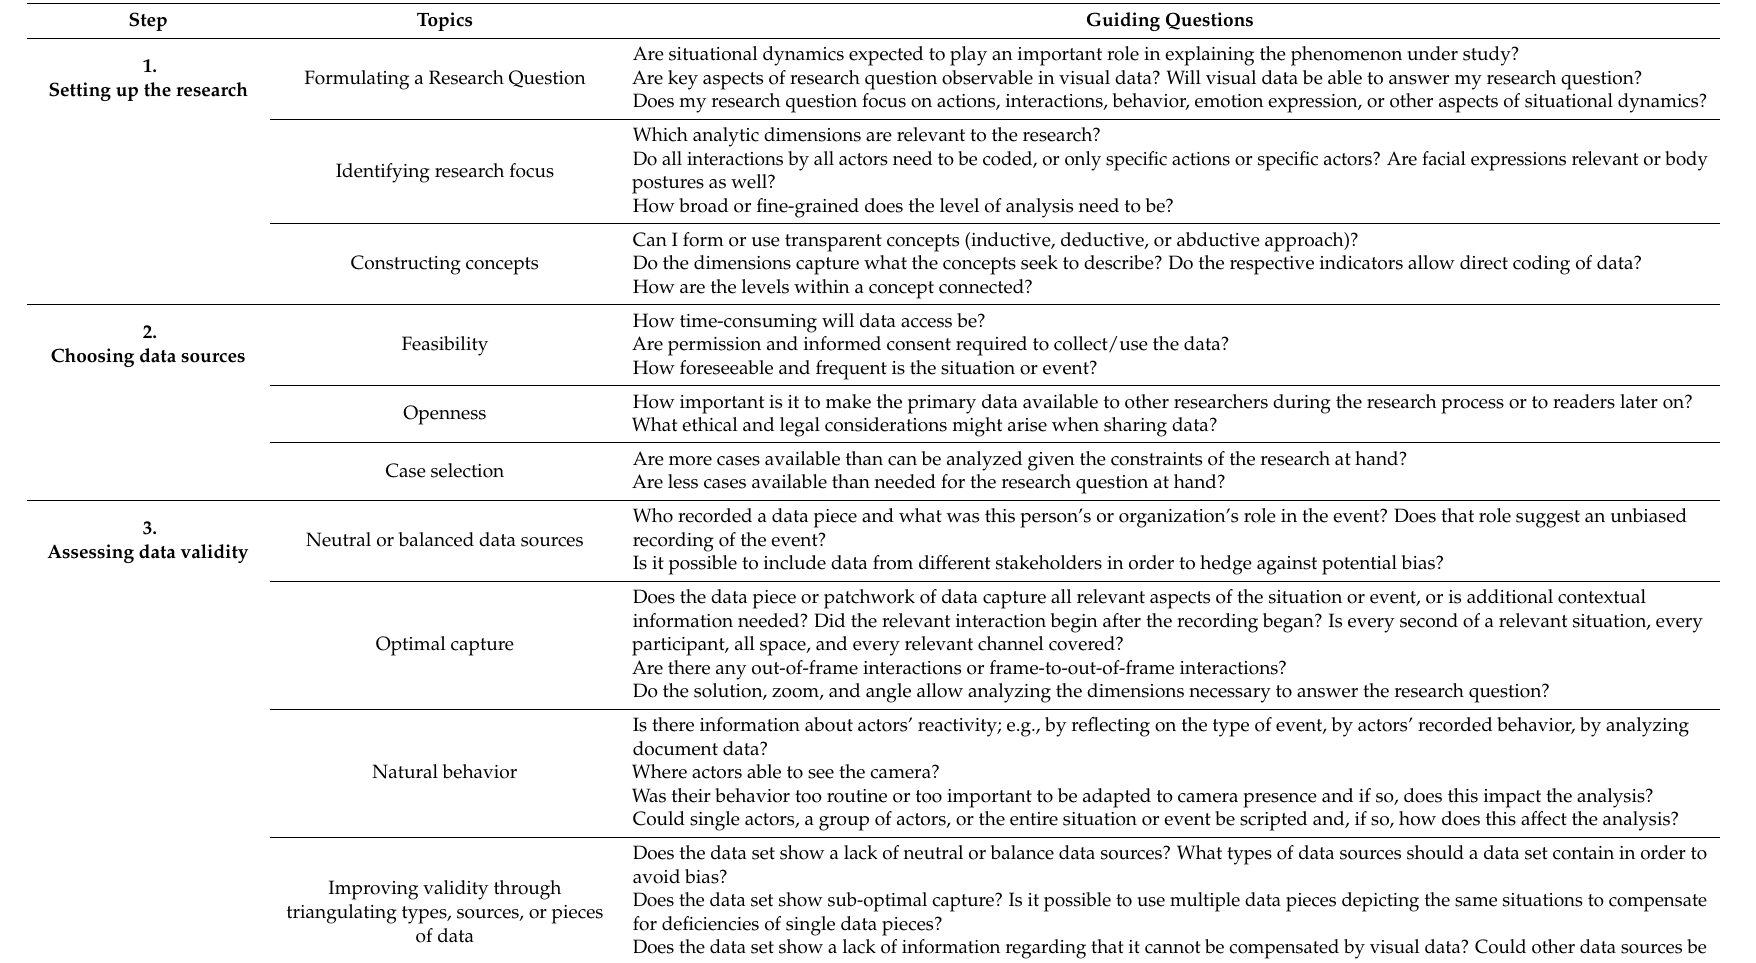
Table A1. Overview Table of Key Issues and Challenges in five-step VDA Research